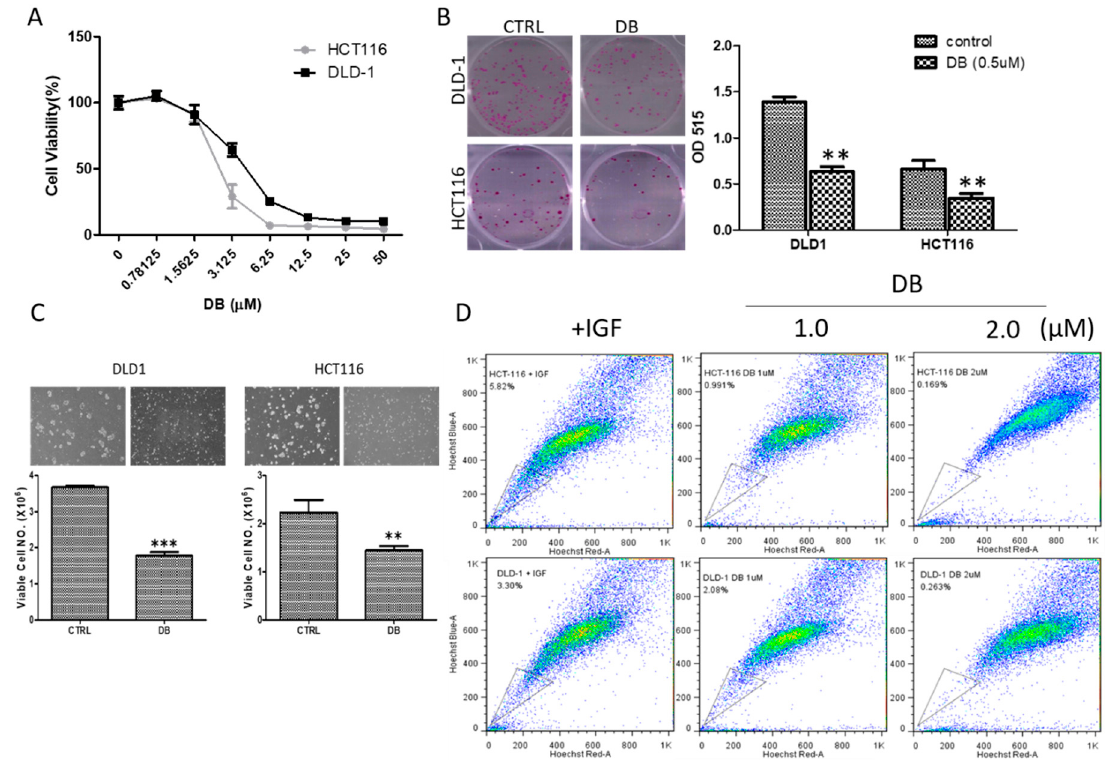
Figure 3. Destruxin B (DB) treatment suppressed tumorigenesis of 5-FU-resistant colon cancer cells. ( A ) Cell viability assay of IGF1-trained colon cancer cell lines in response to DB treatment. Both 5-FU resistant HCT116 and DLD-1 cells were sensitive towards DB treatment, as reflected by their respective IC50 values, 3.04 and 4.99 μ M. Colony ( B ) and tumor sphere ( C ) formations were also significantly reduced by the DB treatment in both cell lines. ( D ) Side-population (SP) assay demonstrated that DB dose-dependently decreased the percentage of SP cells in both IGF1-cultured HCT-116 and DLD-1 cells. (** p ≤ 0.01 and *** p ≤ 0.001).